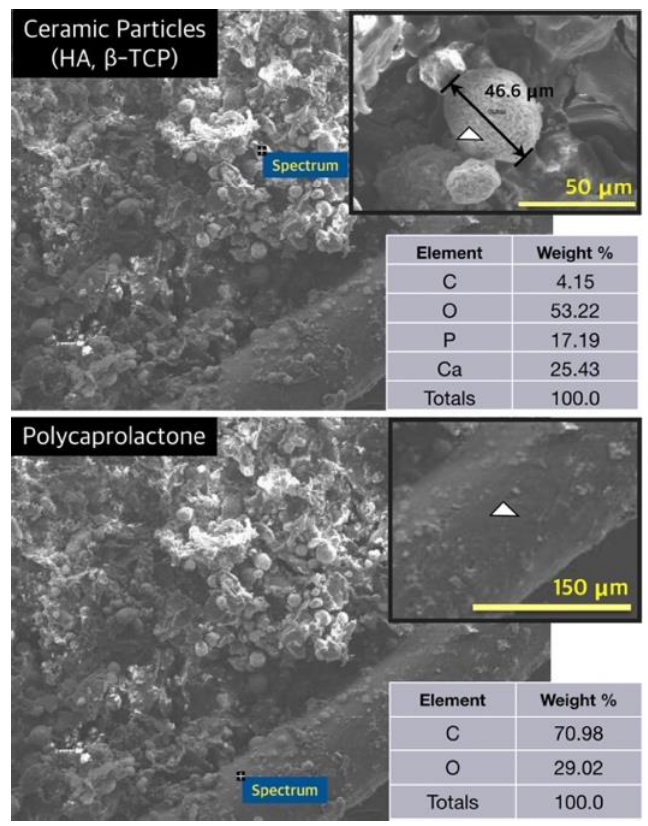
Figure 4. Analysis of energy-dispersive spectroscopy (white triangle: measured point).